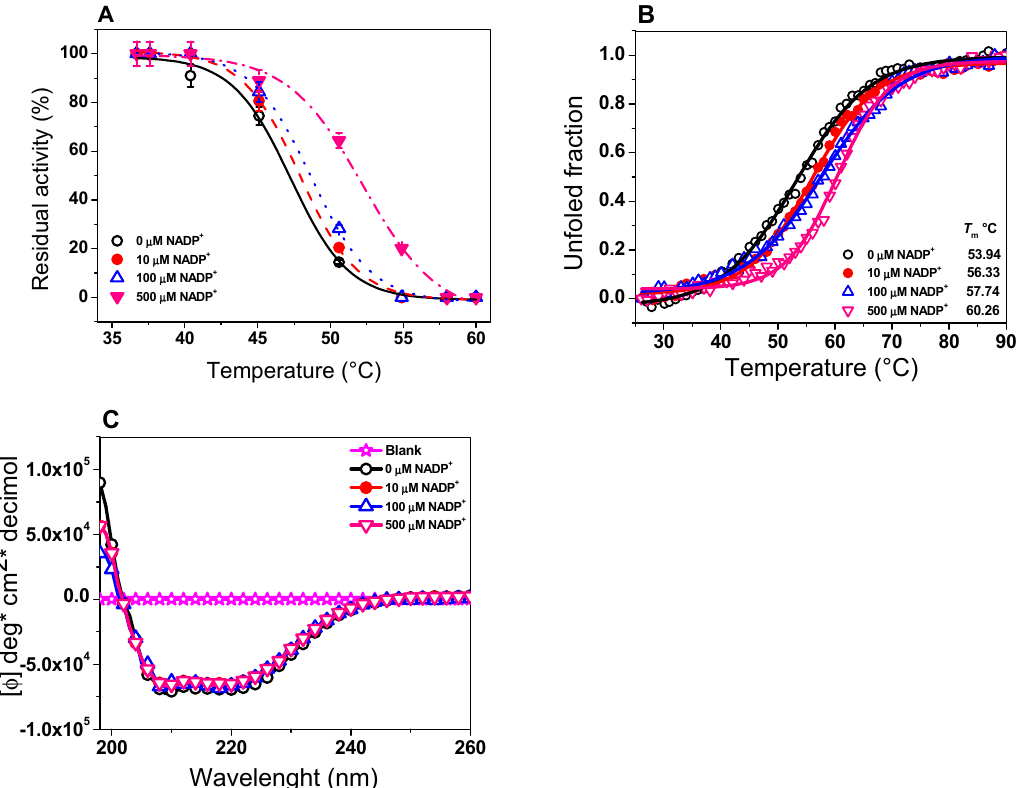
Figure 6. Evaluation of the protein stability of the TvG6PD::6PGL protein. ( A ) Thermal inactivation assays of the TvG6PD::6PGL protein. ( B ) Thermal stability of the Tv G6PD::6PGL protein, and ( C ) Far-UV circular dichroism (CD) spectra of the TvG6PD::6PGL protein. These experiments are representative of triplicate experiments.